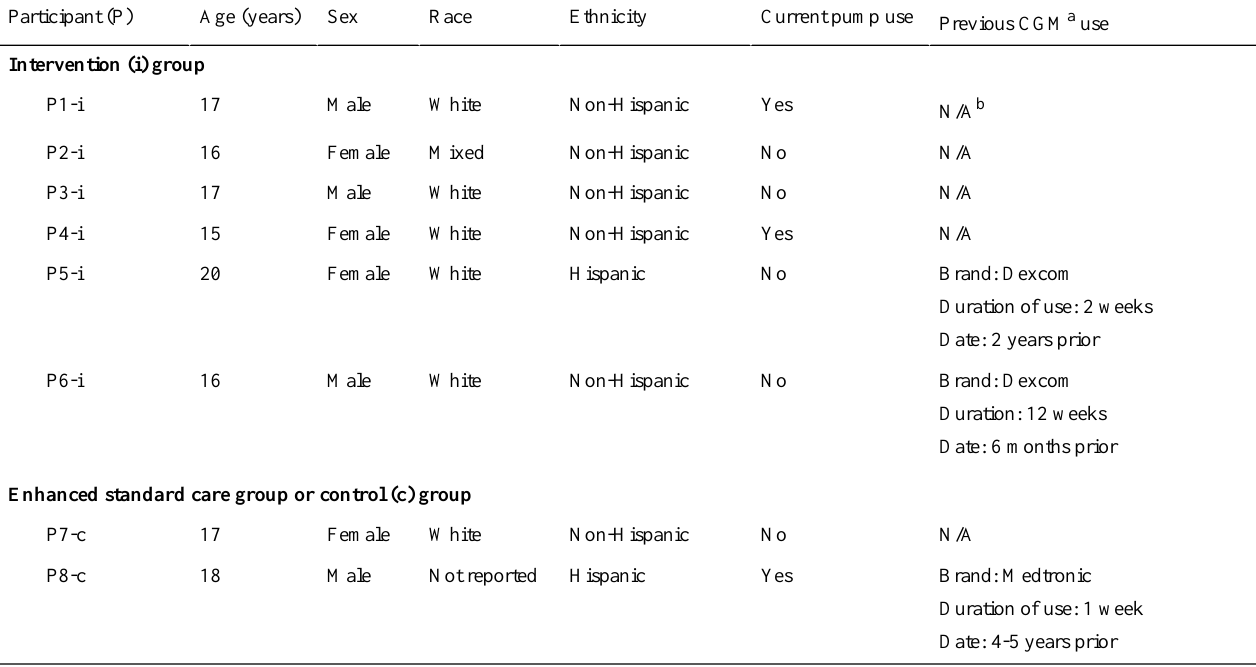
Table 3. Baseline characteristics and clinical features of the enrolled